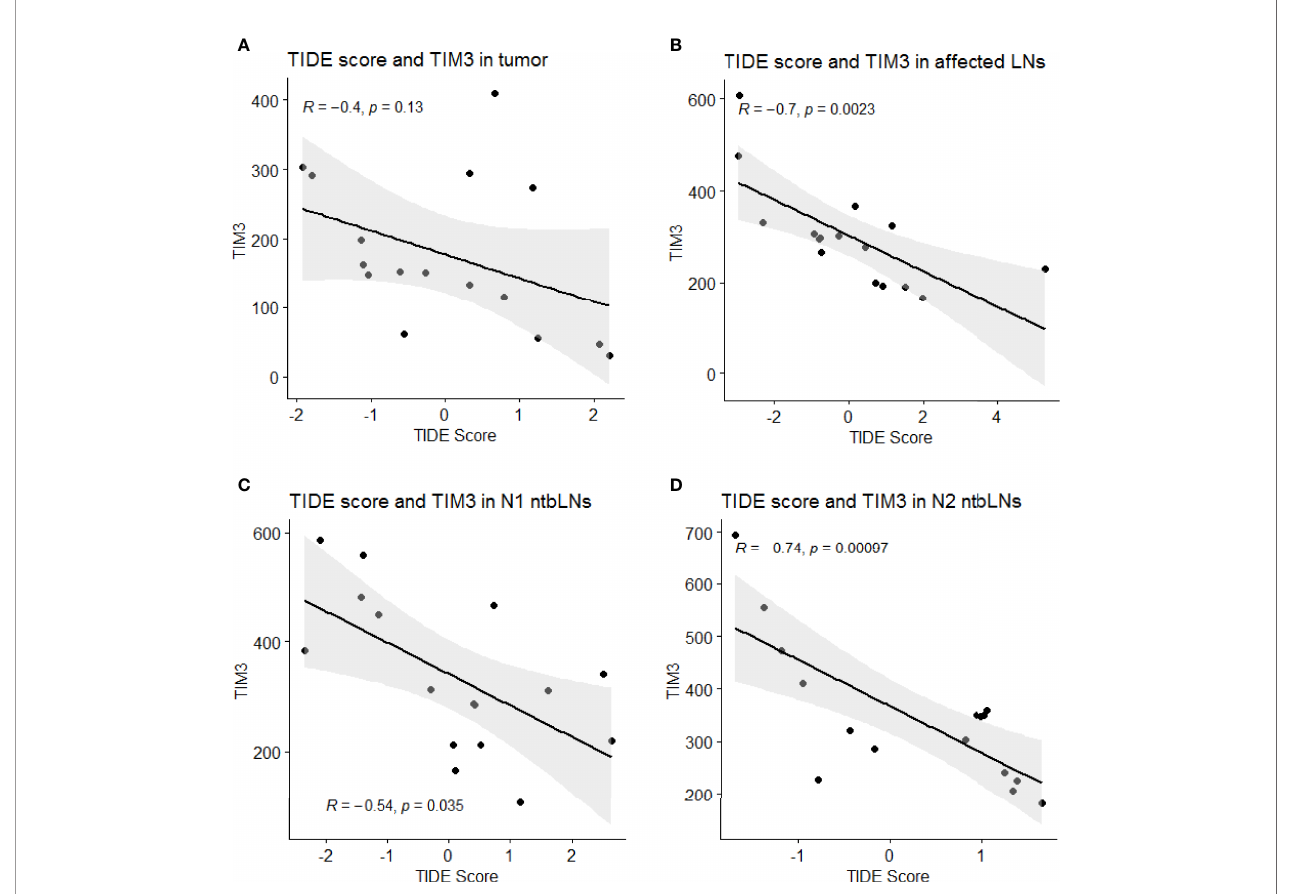
FIGURE 3 | Scatterplots of TIDE scores and TIM-3 expression values in (A) tumor, (B) affected LNs, (C) N1 ntbLNs and (D) N2 ntbLNs with regression line and 95% con fi dence intervals.